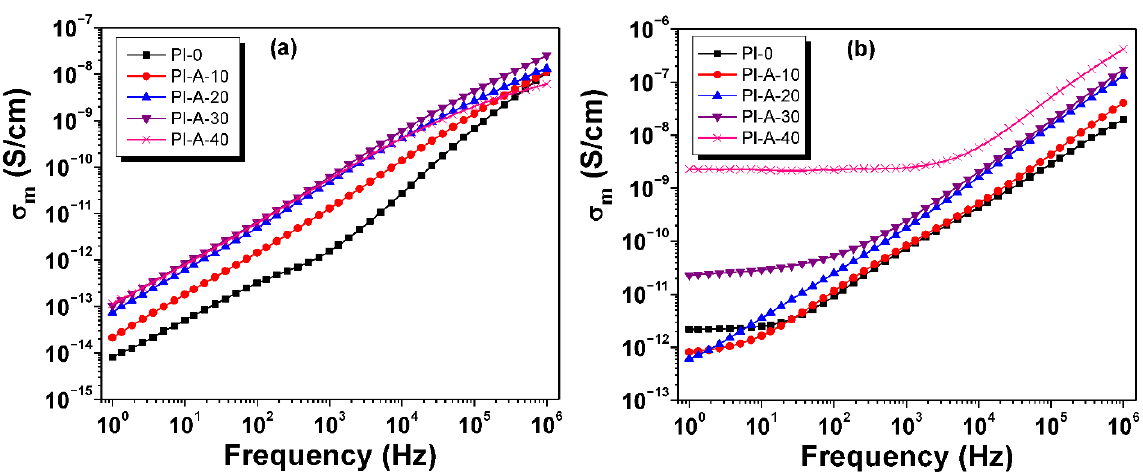
Figure 10. The frequency evolution of measured conductivity at 25 °C ( a ) and 250 °C ( b ) for PI-0, PI-A-10, PI-A-20, PI-A-30, and PI-A-40.